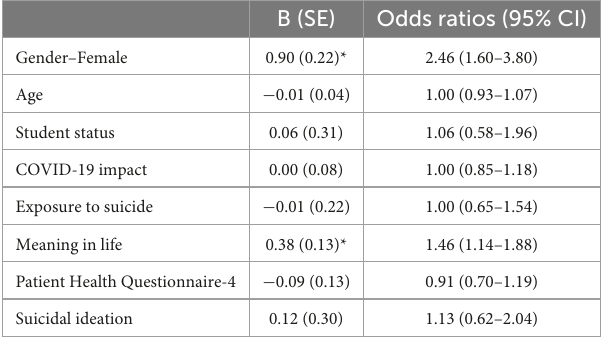
TABLE 5 Logistic regression of help-seeking behaviors on associated factors in the distress